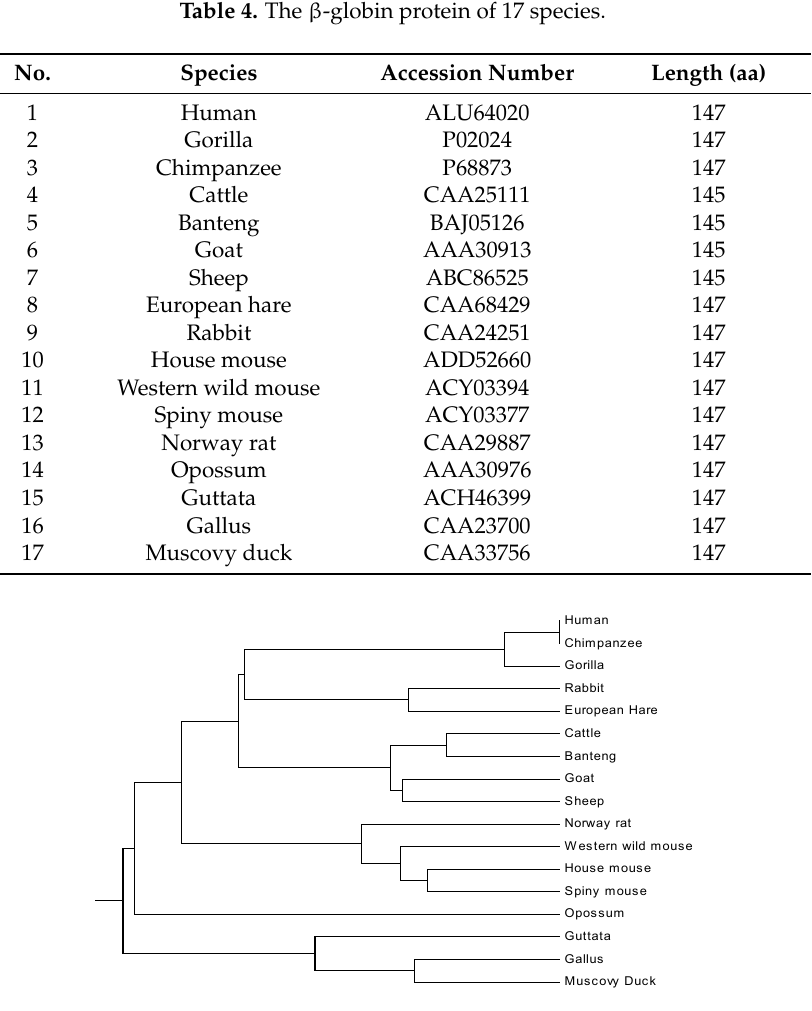
Figure 2. The relationship tree of 17 species.